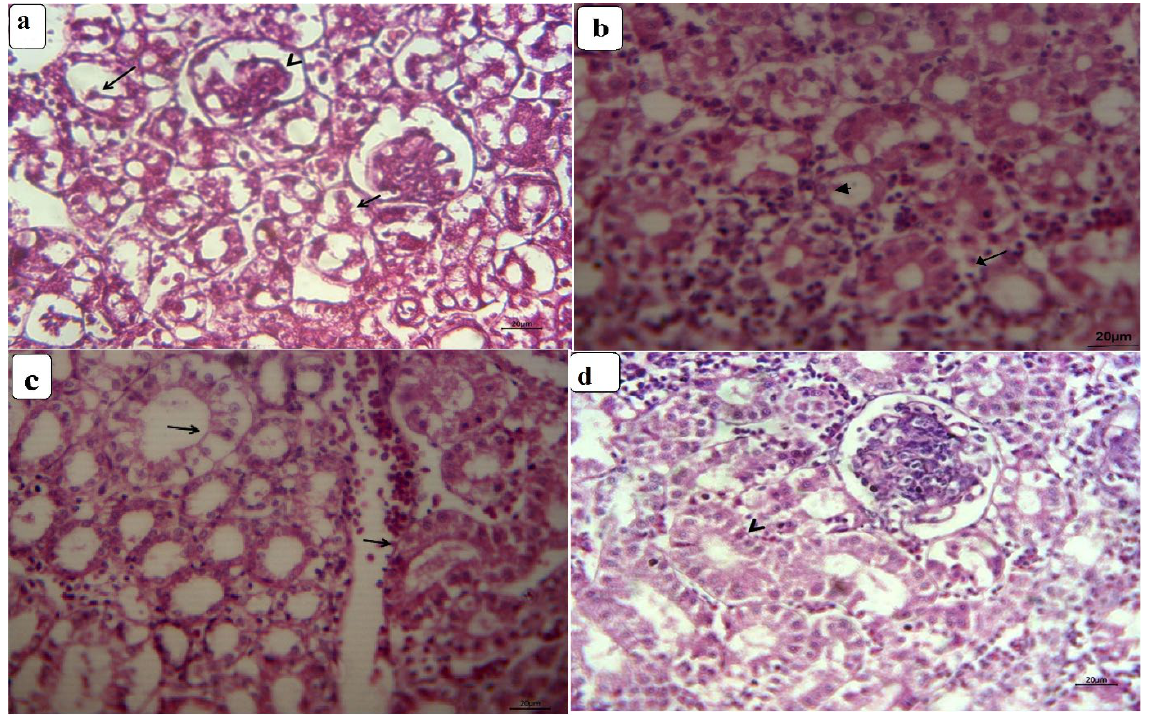
Figure 3. Photomicrographs of kidney sections from CuSO 4 -intoxicated and vitamin-treated groups at the 6th week: ( a ) the kidney of CuSO 4 -intoxicated chickens show pronounced oncotic necrosis of renal tubules (arrow) and glomeruli (arrowhead); ( b ) the kidney of the CuSO 4 + vitamin C group show degeneration and necrosis of some tubular epithelia (arrow); ( c ) the kidney of the CuSO 4 + vitamin E group shows normal renal parenchyma (arrowhead) with mild interstitial lymphocytic aggregation (arrow); ( d ) the kidney of the CuSO 4 + vitamin C + vitamin E group shows normal nephron segments and intense regenerative attempts in the tubules (arrow).